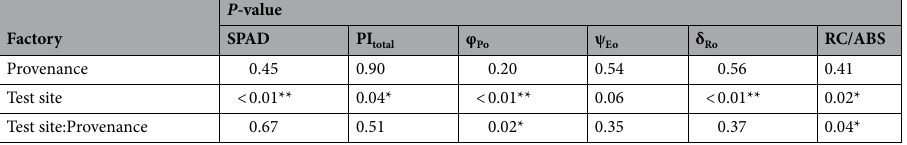
Table 5. The interaction among provenances, test site, and test site:provenance analysis of Quercus liaotungensis seedlings. *Significant difference at the 0.05 level, and **significant difference at the 0.01 level.